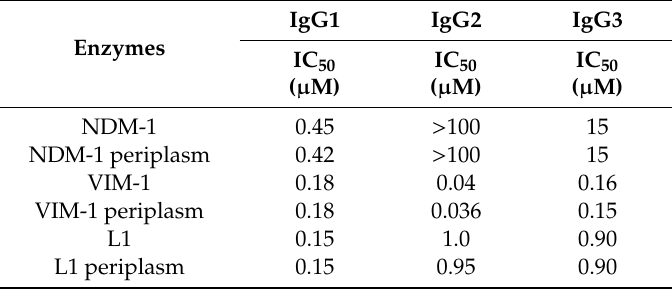
Table 2. Half maximal inhibitory concentration (IC 50 ) calculated for IgG1, IgG2, and IgG3